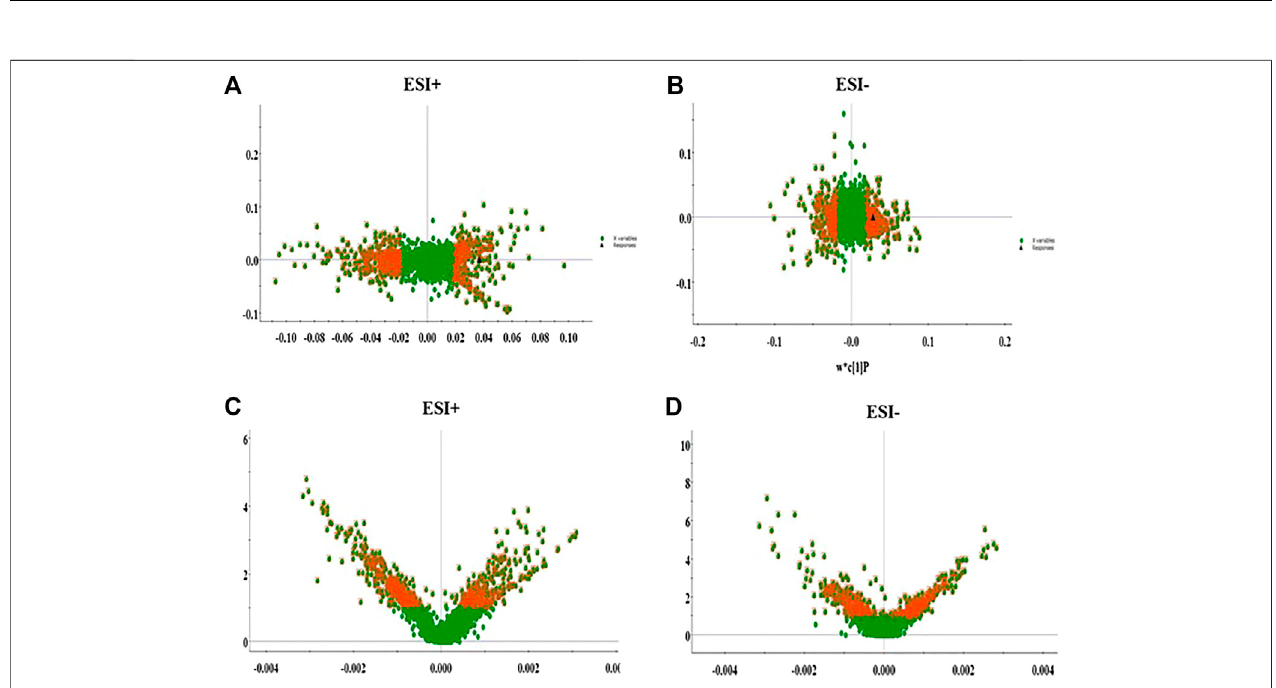
FIGURE5| TheloadingplotforOPLSmodelbetweenNC andLCgroupinESI+andESI-mode (A,B) .VIPplotforOPLSmodelbetweenNCand LCgroupinESI+ and ESI- mode (C,D) .